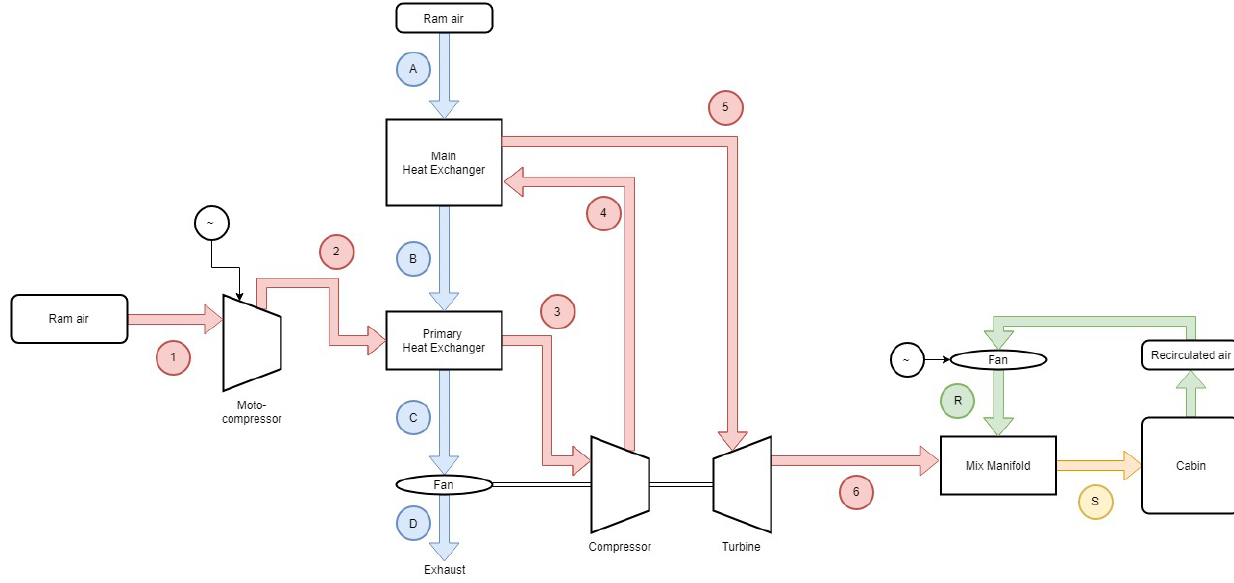
Figure 1. Diagram of the ECS architecture